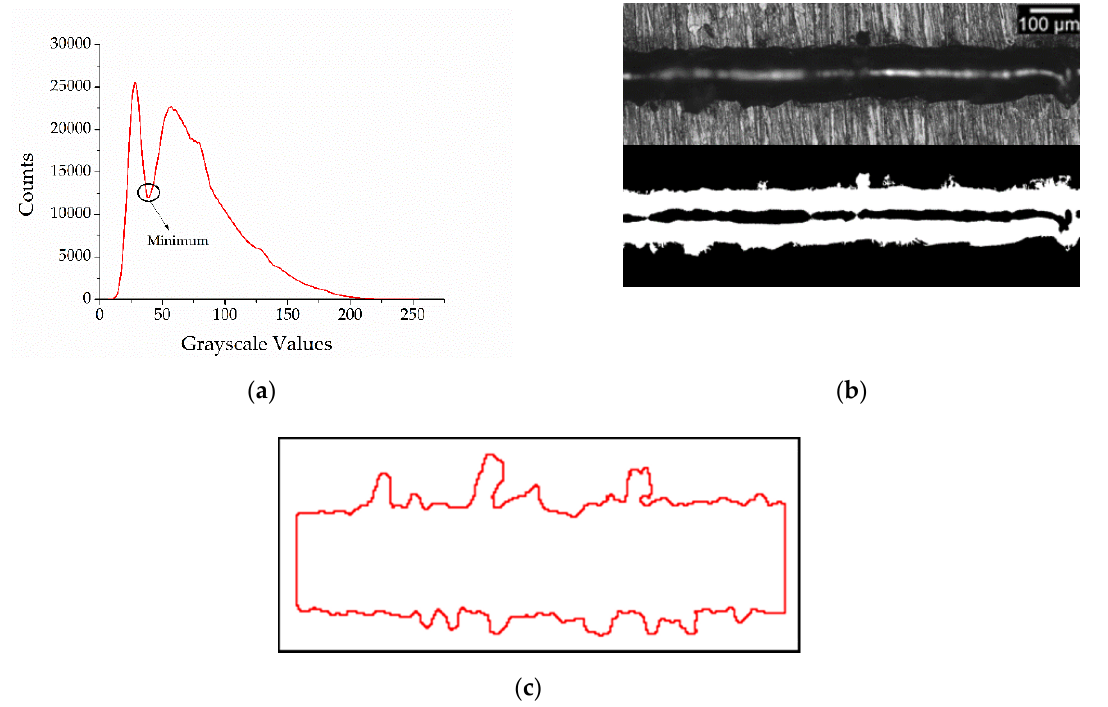
Figure 1. Example of the greyscale histogram used to realize the automatic thresholding ( a ), the original image transformed in a binary one ( b ) and ROI elaborated by the software ( c ) .